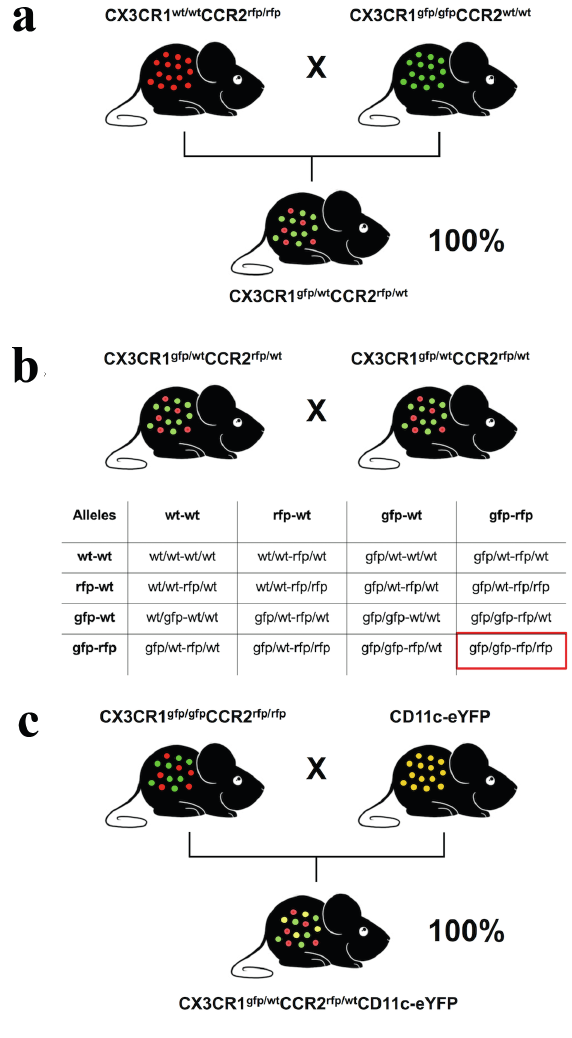
Figure 4 - Breeding strategy to generate a triple fluorescence strain. ( a ) CCR2 knockout mice that both CCR2 alleles were replaced by an RFP sequence (CCR2 rfp/rfp ) were bred with CX3CR1 knockout mice which CX3CR1 alleles were knocked out and replaced by a GFP sequence (CX3CR1 gfp/gfp ). The F1 offspring was 100% heterozygote for both receptors (CX3CR1 gfp/wt CCR2 rfp/wt ). ( b ) To further generate double- knockout mice (CX3CR1 gfp/gfp CCR2 rfp/rfp ), heterozygous mice for CX3CR1 and CCR2 (F1) were bred. Possible genotypes of the offspring of this breeding were illustrated by the allelic combination of F1 animals showing a ratio of 1/16 of double-knockout mice (F2). ( c ) To generate a mouse with triple fluorescence, F2 double-knockout mice (CX3CR1 gfp/gfp CCR2 rfp/rfp ) bred with mice expressing e-YFP under control of CD11c. Then, were reached a 100% progeny of heterozygous mice for the three receptors (CX3CR1, CCR2 and CD11c) and triple fluorescence (GFP, RFP and YFP,